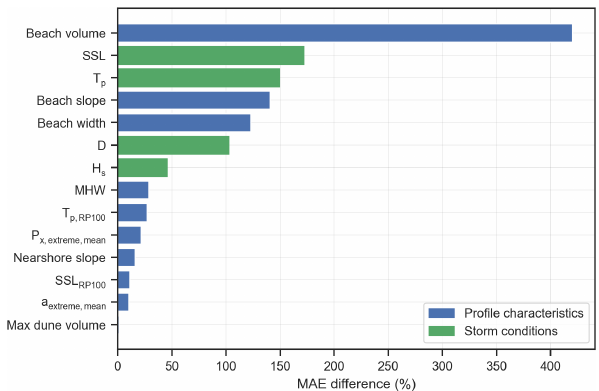
Figure 11. Input parameter importance using a permutation impor- tance approach. The bars indicate the mean MAE difference be- tween the MAE when permutating a single-input parameter and the MAE of the benchmark cases with no